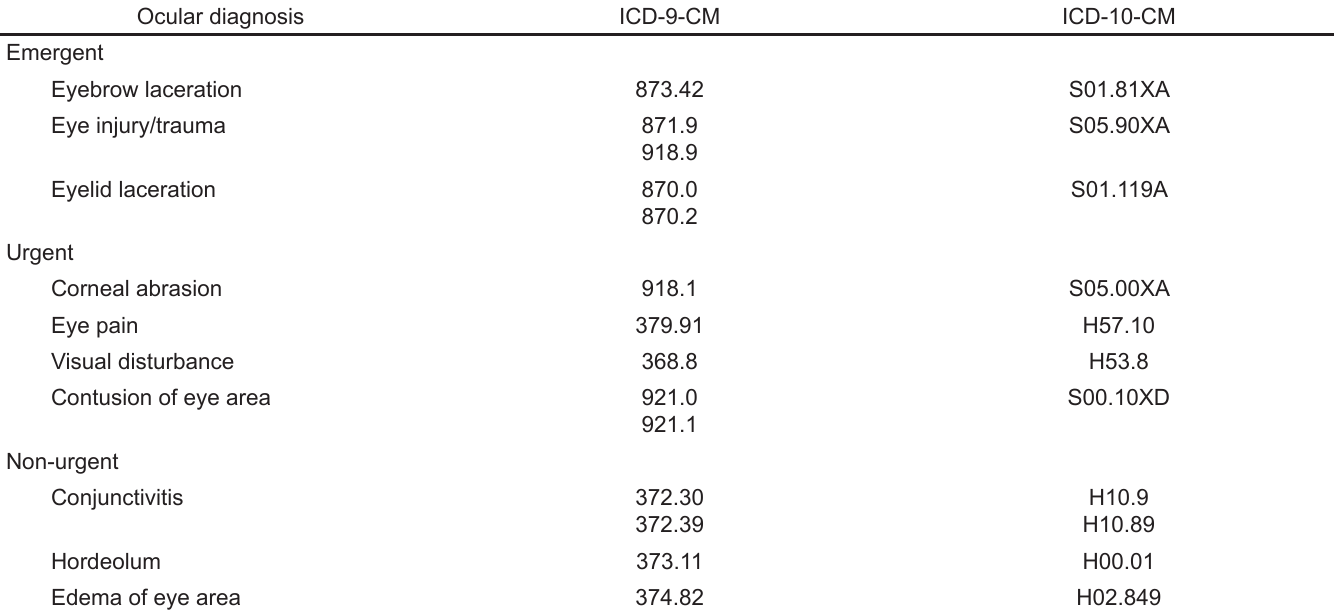
Table 1. International Classification of Disease s codes used to define urgency categories of ocular diagnoses made during emergency department